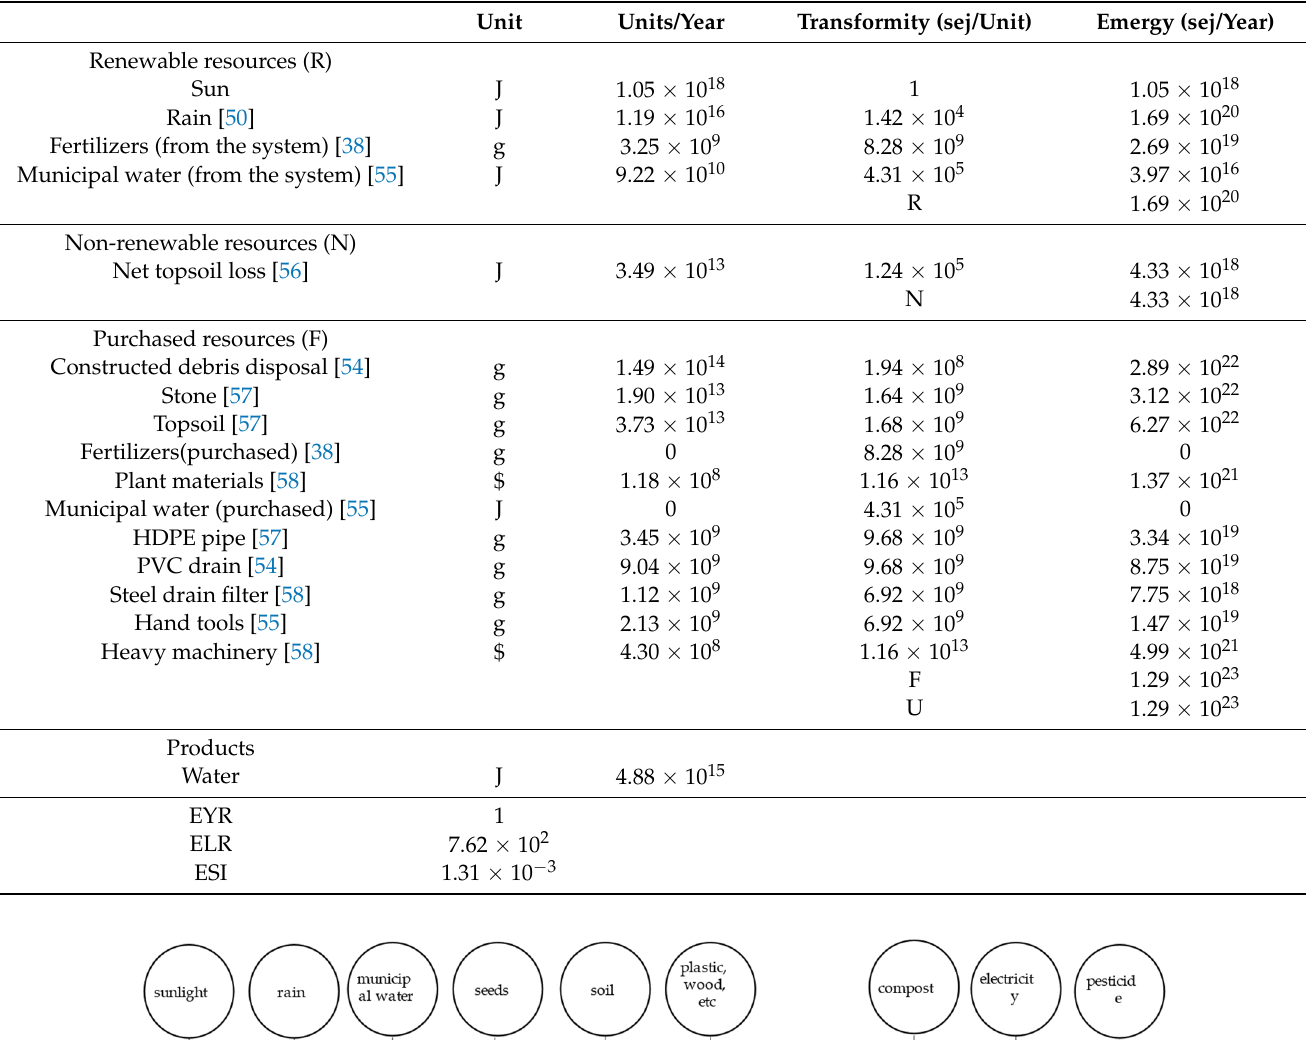
Table 6. Emergy calculation of rainwater garden subsystem (after).